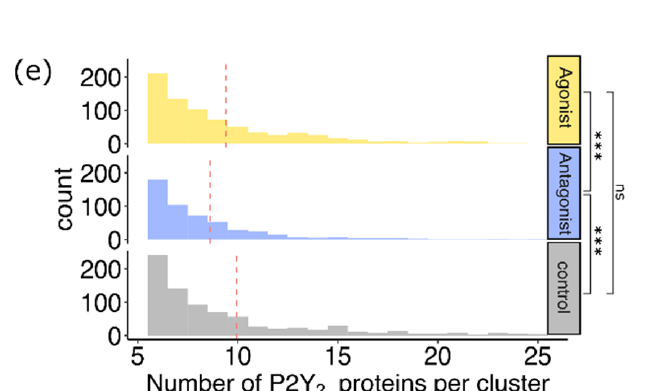
Figure 3. Comparison of P2Y 2 protein clustering in AsPC-1 cells under control, agonistic and antago- nistic conditions. ( a ) Density of P2Y 2 proteins under control, agonistic and antagonistic conditions. ( b ) Percentage of P2Y 2 detected as monomers under control, agonistic and antagonistic conditions. ( c ) Percentage of P2Y 2 forming dimers under control, agonistic and antagonistic conditions. ( d ) Per- centage of P2Y 2 receptors forming clusters of more than 5 proteins under control, agonistic and antagonistic conditions. ( e ) Number of P2Y 2 proteins per cluster under control, agonistic, and an- tagonistic conditions. Control conditions depicted in grey with circular points, agonist in yellow with triangular points and antagonist in blue with square points. Significance values from paired Wilcoxon sum tests adjusted p values >0.05 = ns, <0.05 = *, <0.01 = **, <0.001 = ***. n = 25, 27, and 26 ROIs, respectively.